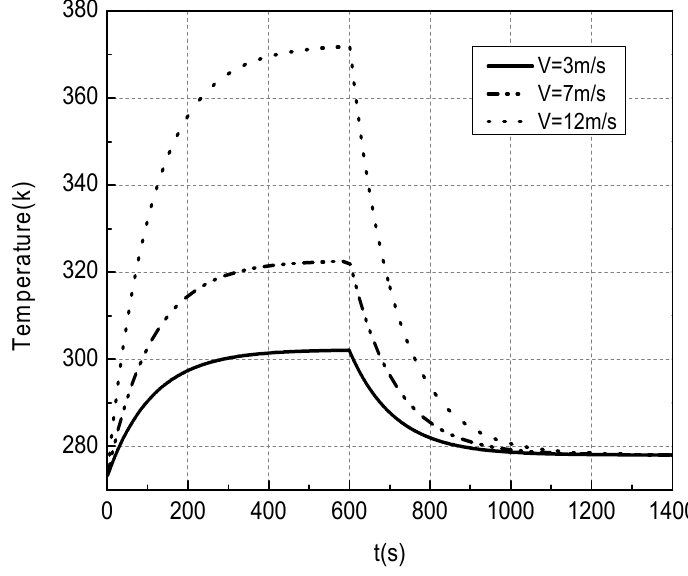
Figure 8. Thermal behaviour of the DFIG stator